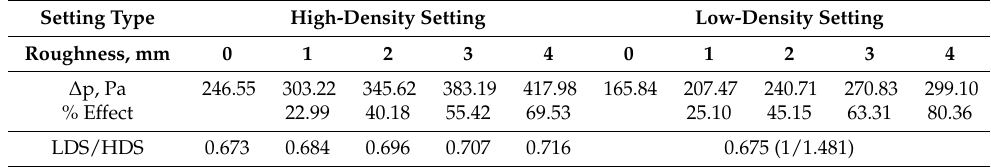
Table 7. Pressure drops across the entire setting for different brick surface roughness